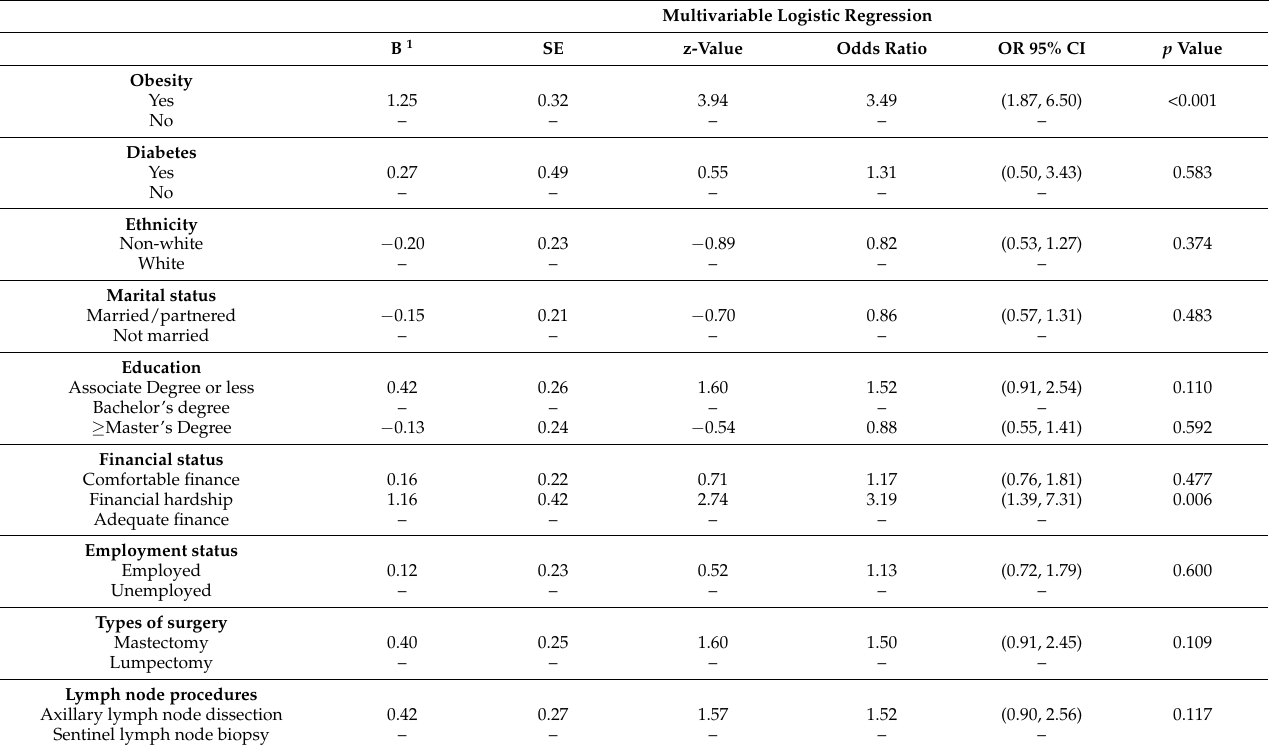
Table 4. Multivariable logistic regression for lymphatic pain ( N =